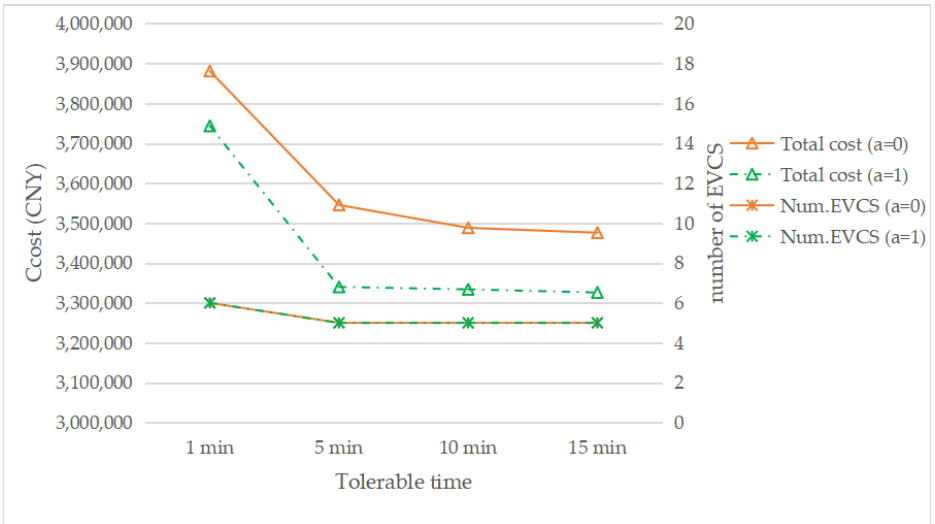
Figure 11. The total cost and EVCS number with changing the tolerable time.